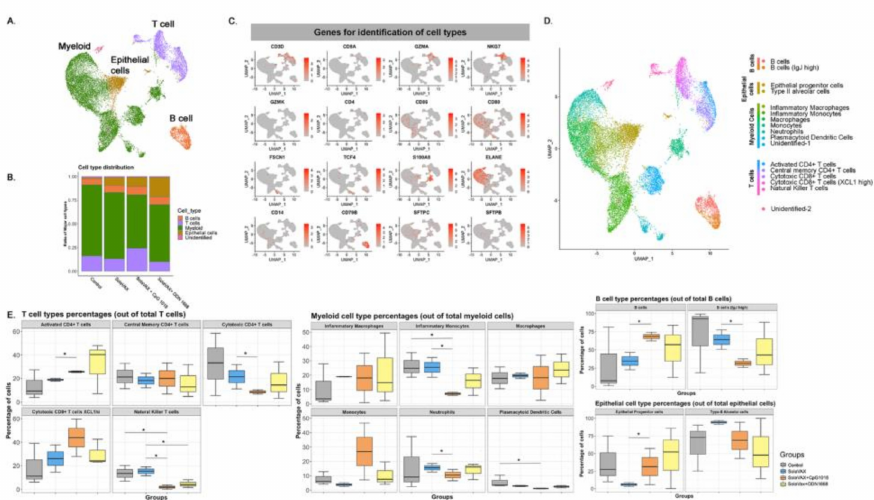
Figure 7. Single-cell transcriptomes of lungs from non-vaccinated and SolaVAX vaccinated hamsters. ( A ) merged UMAP visualization of 5466 single cells Control, SvX, CpG and ODN vaccinated hamsters via IM administration. Colors indicate grouping of cells into T cells, myeloid, B cells and epithelial cells based on transcriptional similarity. ( B ) Proportion of T, B, myeloid and epithelial cell types in each group. ( C ) Normalized expression of known genes on a UMAP plot to identify different cell types. ( D ) UMAP projection to visualize 17 different cell types visualized after sub clustering the major cell types at higher resolution. ( E ) Percentage of each cell subtype of T ( left panel ), myeloid ( middle panel ), B cells and epithelial cells ( right panel ). Significance value was calculated using ANOVA. p < 0.05 was considered significant, denoted with